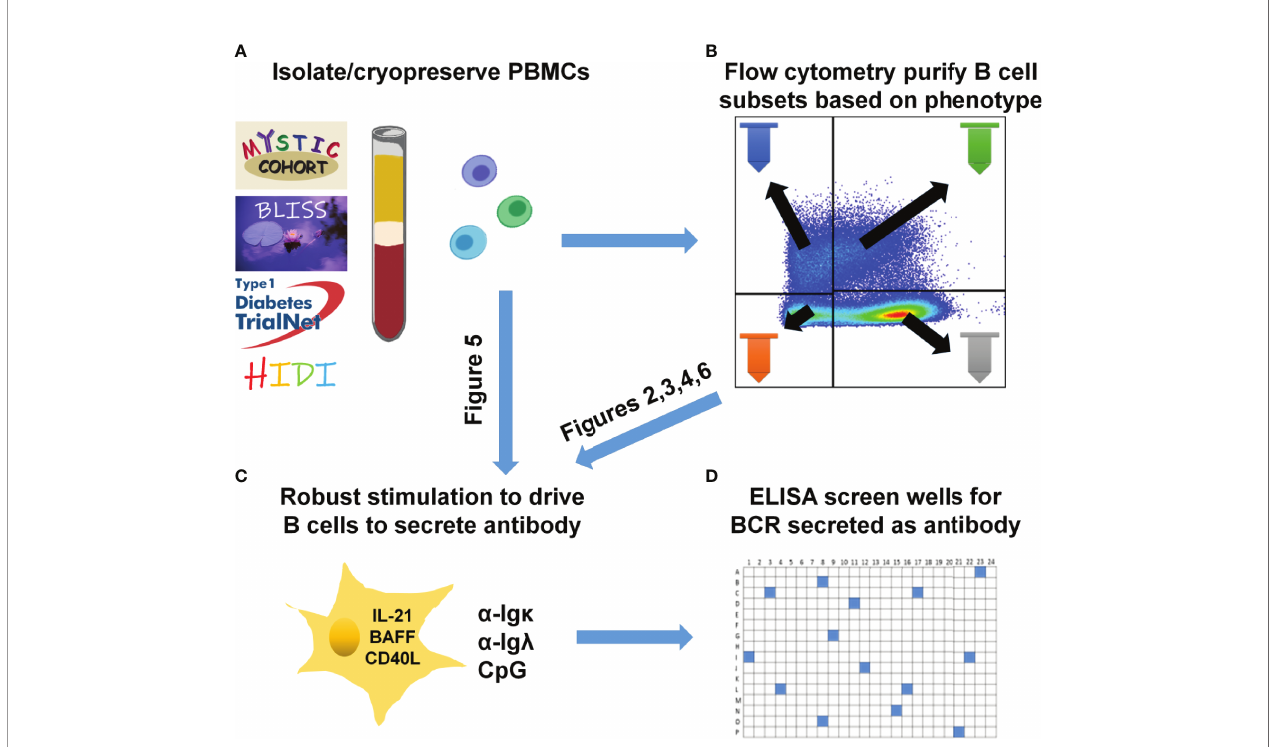
FIGURE 1 | Human B cell stimulation and high-throughput screening methods overview. (A) PBMCs were isolated and cryopreserved from the indicated cohorts. (B) Speci fi c B cell subsets were fl ow cytometry-puri fi ed. (C) As speci fi ed for each fi gure, total PBMCs (A) were plated into 96-well plates or puri fi ed B cell subsets (B) were plated into 384-well plates and stimulated as in Methods to drive B cell proliferation and differentiation into antibody-secreting cells. (D) High-throughput ELISA screening of well supernatants identi fi ed wells containing